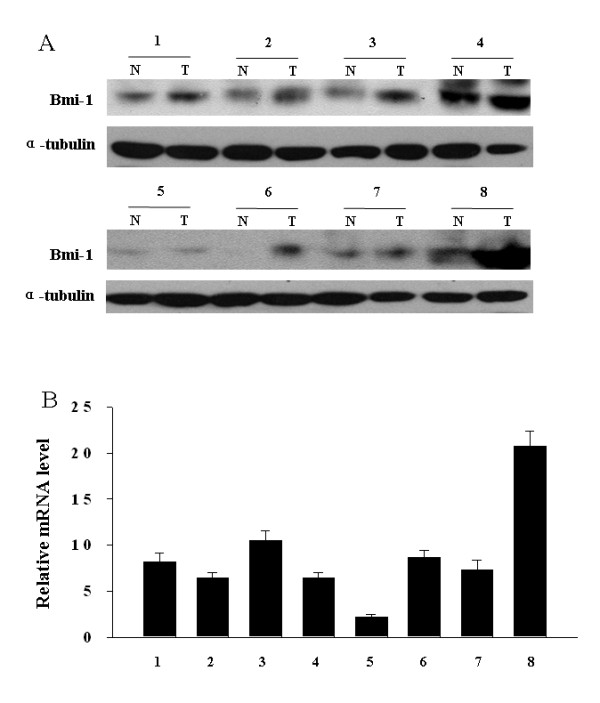
Overexpression of Bmi-1 in ESCC tumors. Eight paired primary esophageal tumors (T) and normal esophageal tissue (N) from the same patient were determined for Bmi-1 expression at protein level by Western blot (A), or at mRNA level by real-time PCR (B). Expression level was normalized by α-Tubulin or GAPDH. Error bars represent standard deviations (SD) calculated from three parallel experiments.